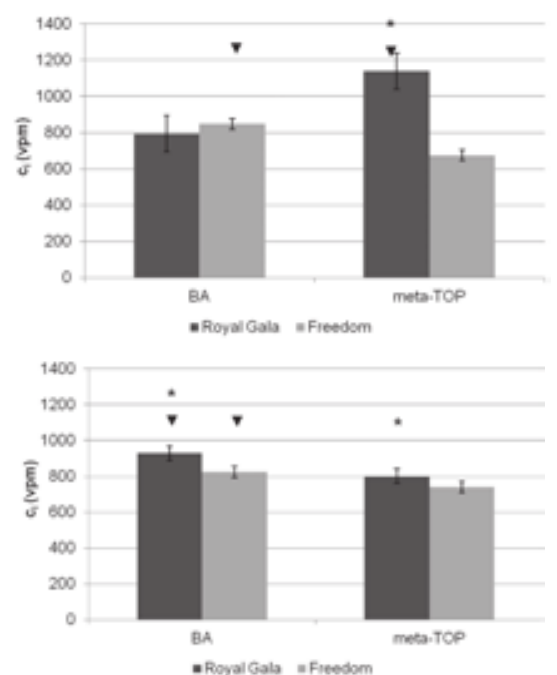
Figure 1. Effects of different cytokinins and apple cultivars on the intercellular CO concentration (c ) at (A) 2.0 µM and (B) 6.0 µM 2 i cytokinin supply. *: means significant (P ≤ 0.05) differences between the apple scion cultivars (‘Royal Gala’ and ‘Freedom’) at the same cytokinin type; ▼ : means significant (P ≤ 0.05) differences between the cytokinin types (BA and meta-TOP) in the same scion cultivar